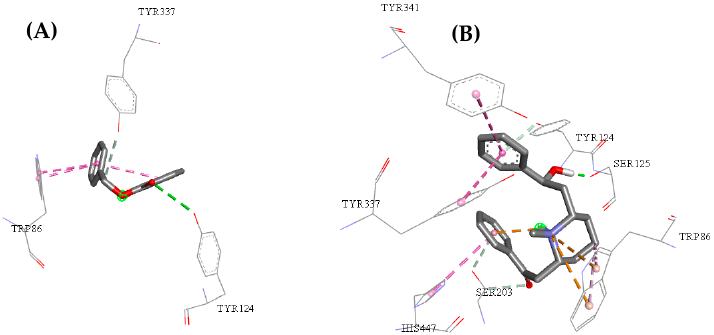
Figure 8. Active site interactions between the human acetylcholinesterase active site and the molecules ZINC00001021 ( A ) and ZINC00001624 ( B ).